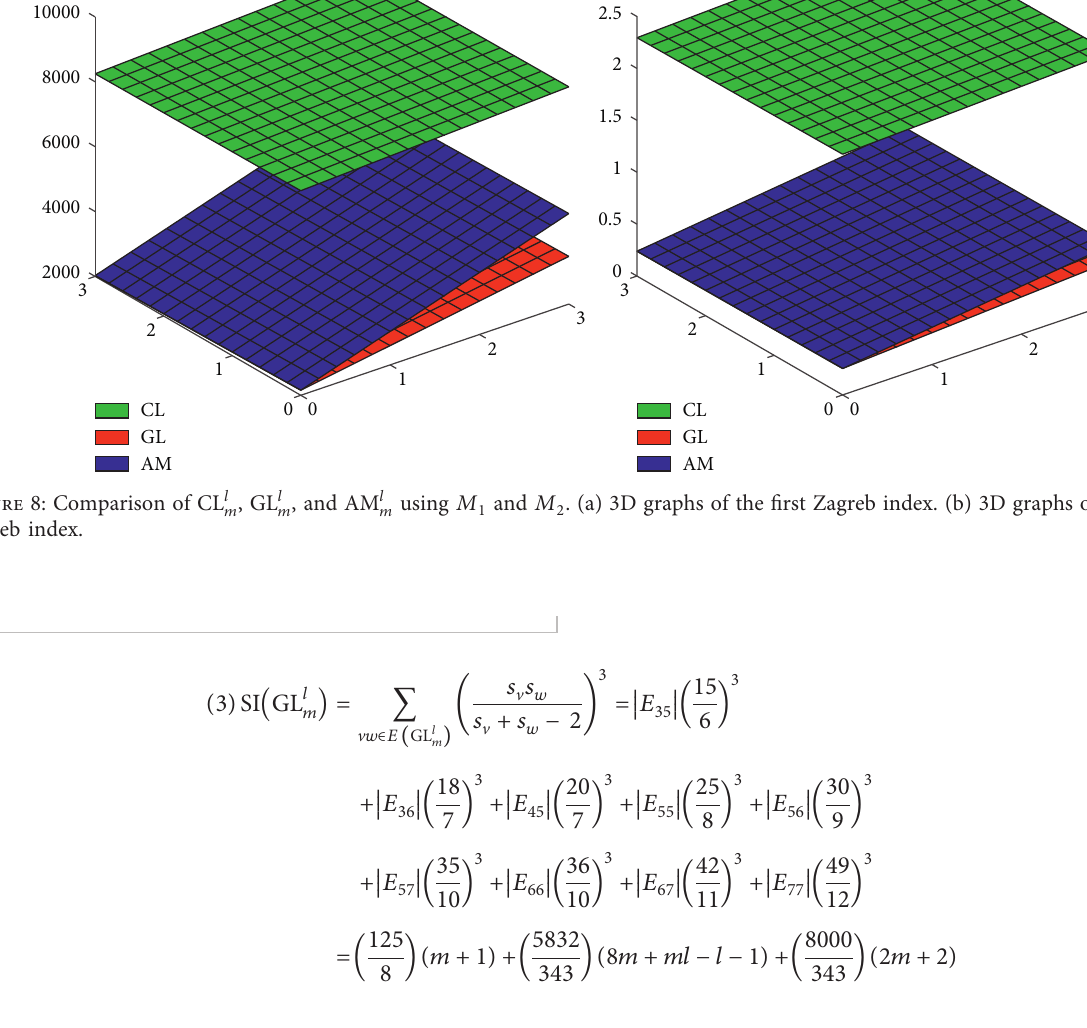
, GL 3 , and AM 5 . 5 6 3